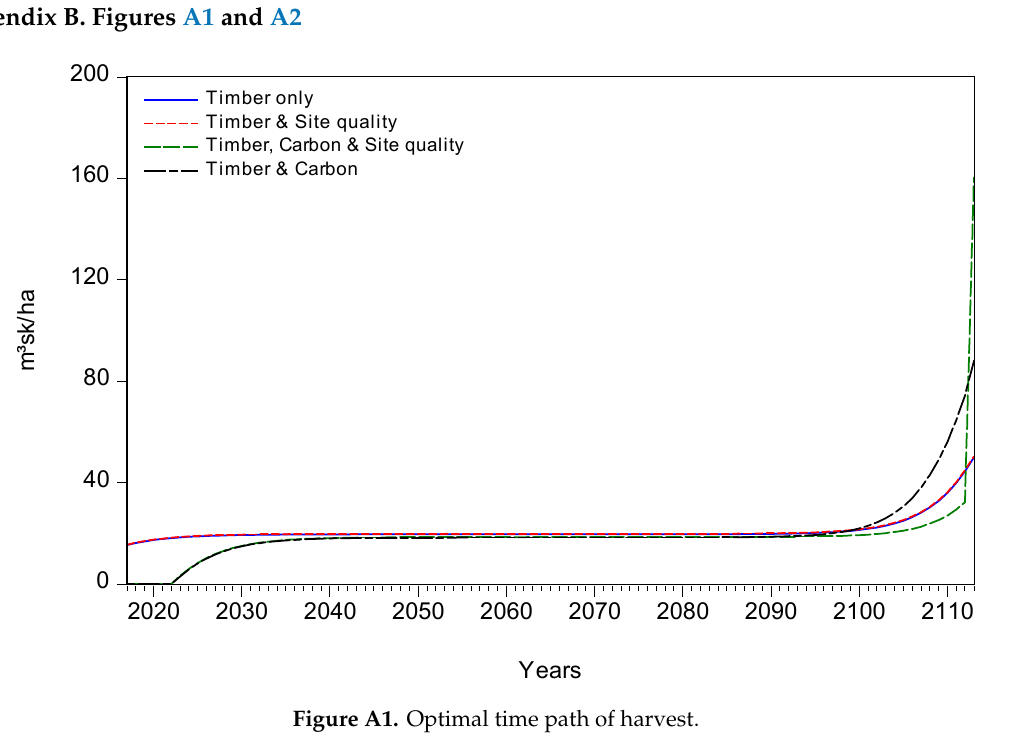
Figure A1. Optimal time path of harvest. Forests 2019 , 10 , x FOR PEER REVIEW Figure B1. Optimal time path of harvest.